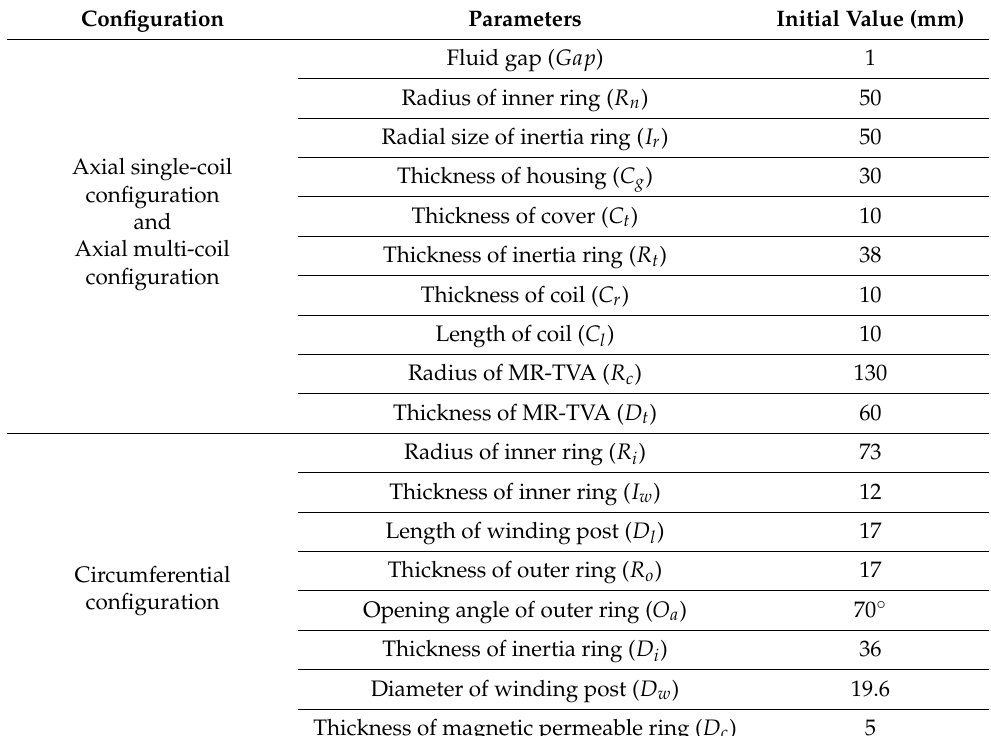
Table 2. Values of fixed parameters of